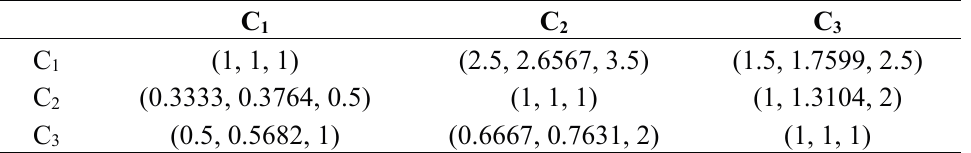
Table 8. The group judgment matrix of the criterion.